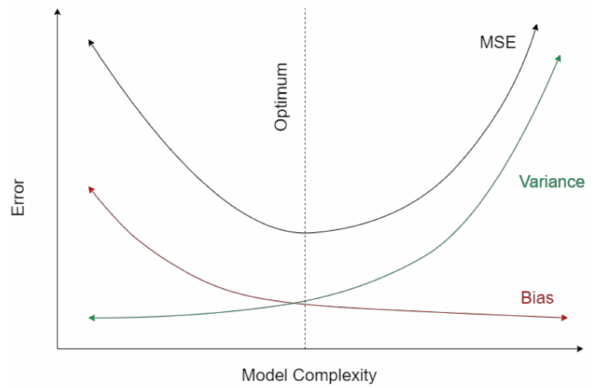
Figure 2. Bias and variance as a function of model